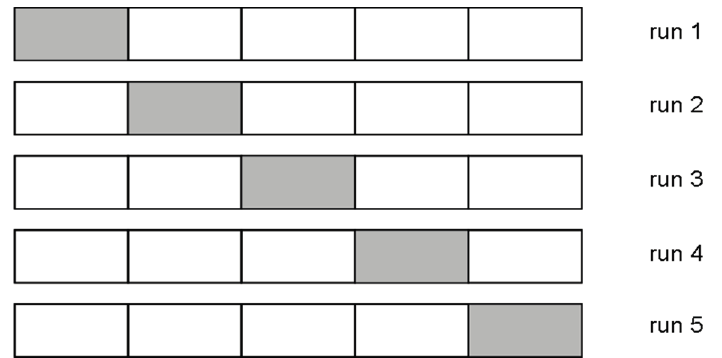
Figure 3. 5-fold Cross